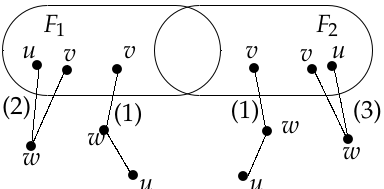
Figure 3. Illustration of a distinguishable pair ( F 1 , F 2 ) under Maeng and Malek’s (MM)* Fig. 3. Illustration of a distinguishable pair ( F 1 , F 2 ) under the MM* model. 321